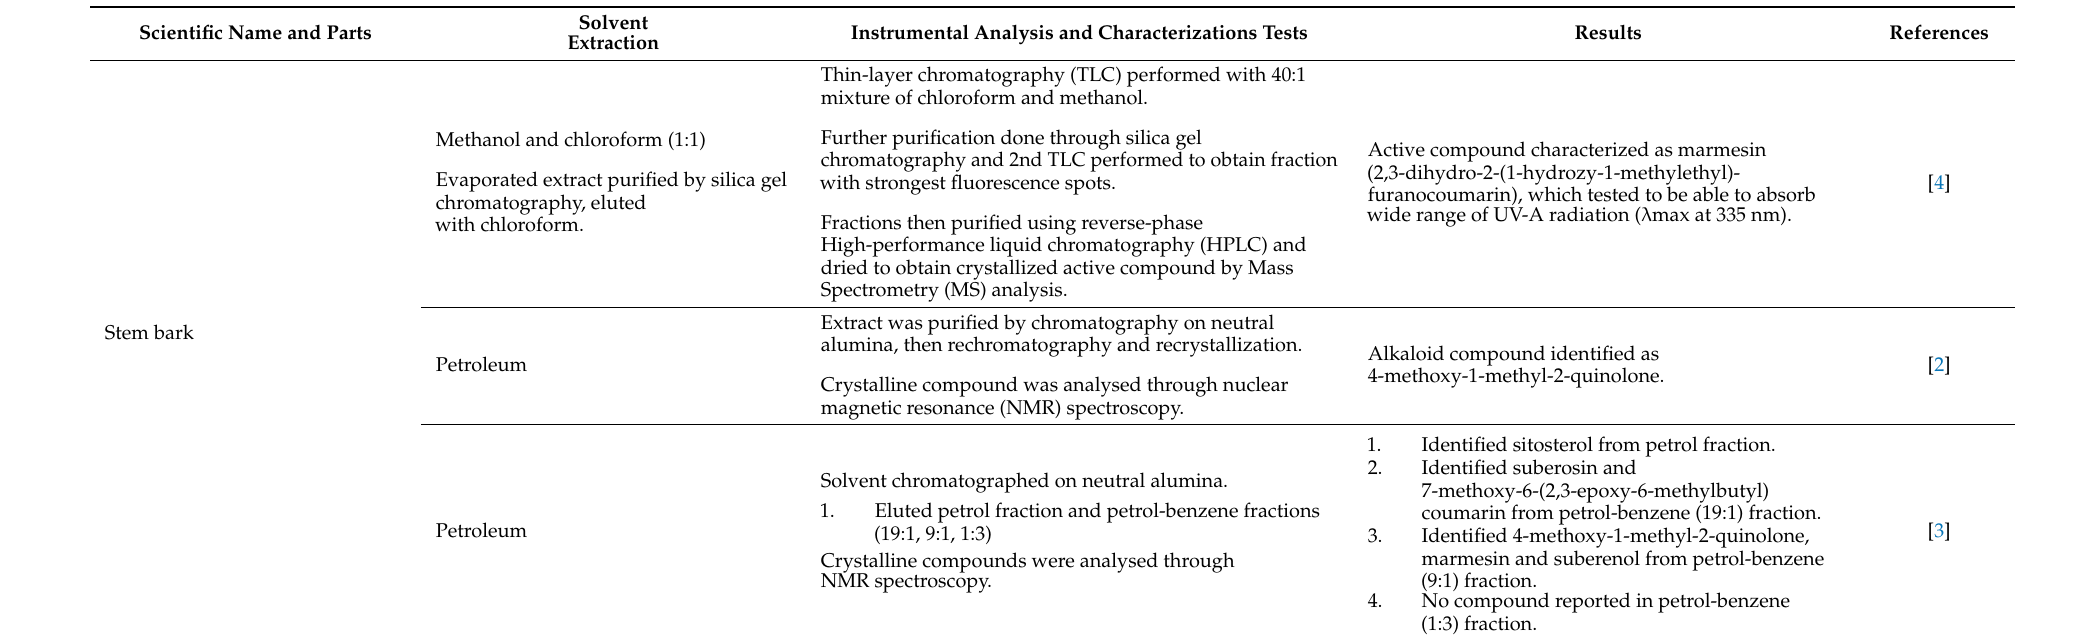
Table 2. Chemical constituents and phytochemical analysis of